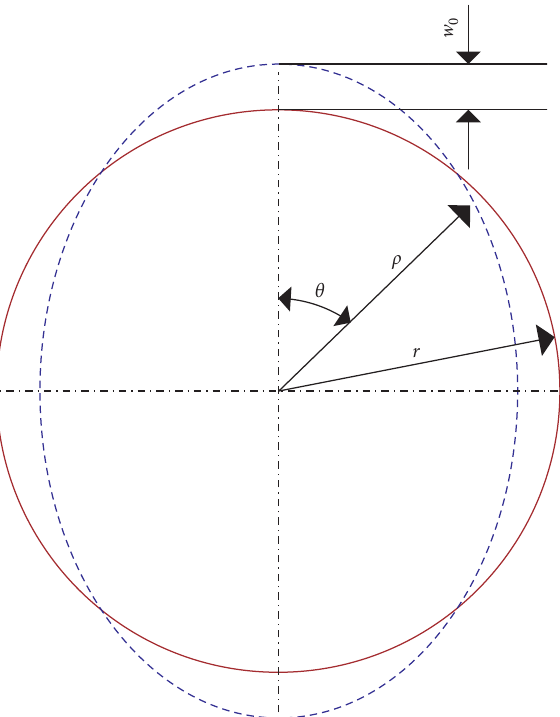
Figure 6: Diagram of cosine cam wave generator.